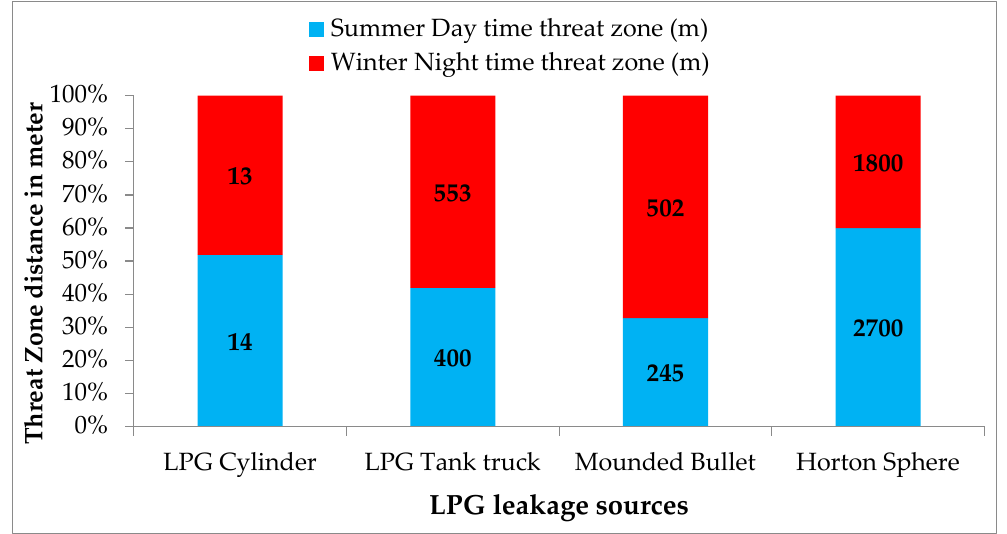
Figure 8. Blast force for 24.13 kPa pressure and 0.6 LEL.